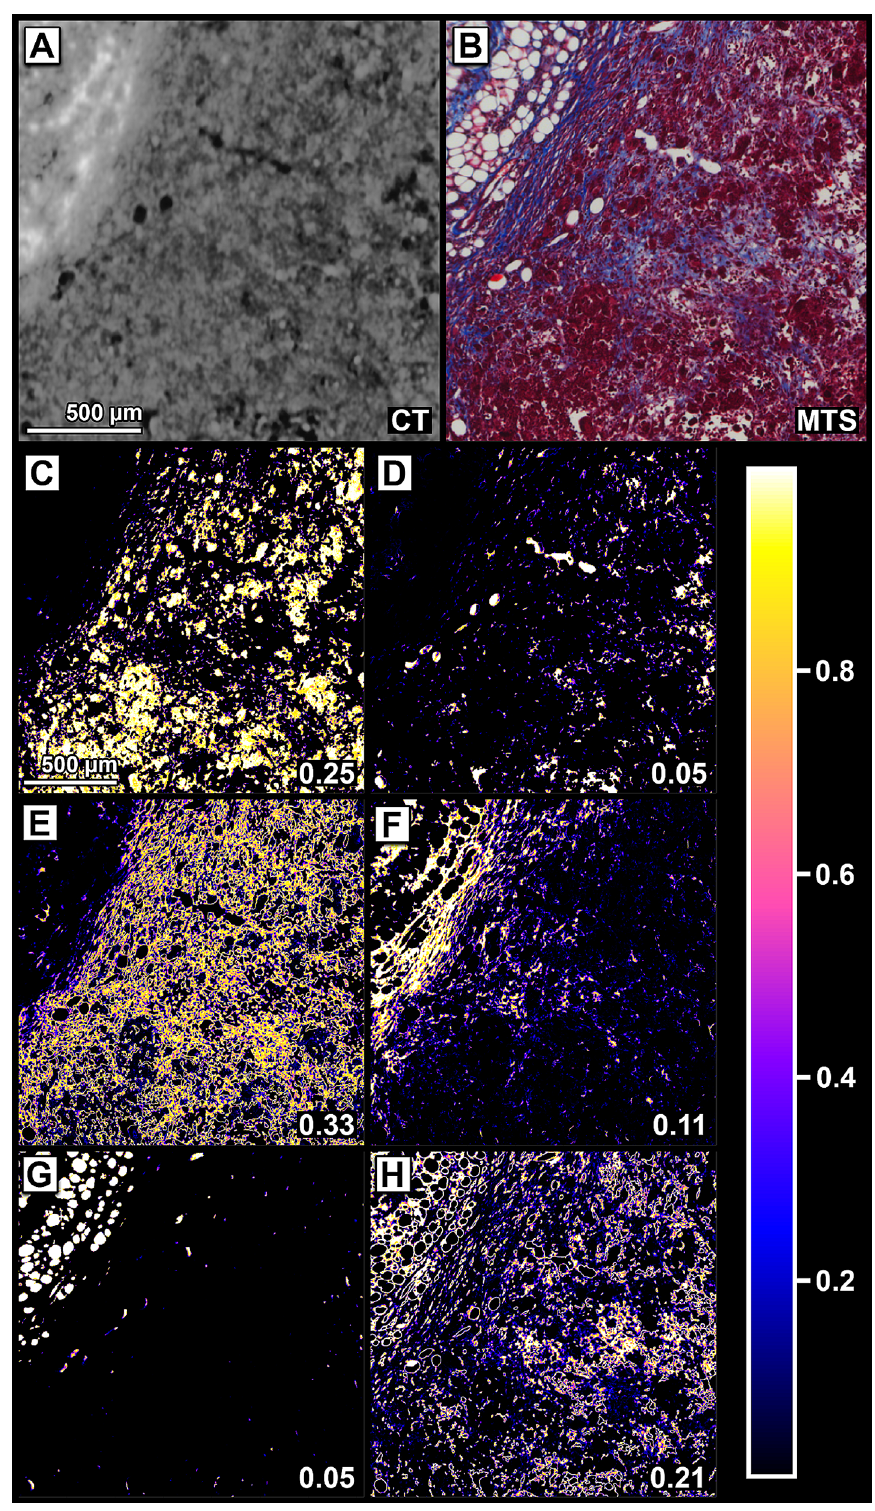
Figure 6. Automatic classification of tissue structures using registered CT and histology. ( A ) CT image. ( B ) MTS histology image matched to the CT image shown in ( A ). ( C – H ) Colour coded probability maps of the six different components of the gaussian mixed model optimized by EM. The colour code for the different probabilities can be seen in the bar. ( C ) Mainly depicts healthy tumour cells. ( D ) Depicts vessels and holes within the tissue. ( E ) Shows NP location, extracellular matrix components. ( F ) Depicts the BaNPs. ( G ) Displays fat cells. ( H ) Displays cell membranes. All images ( C – H ) also state the mix coefficient in the lower right corner. Fibres components ( E ) are the most dominant component with a mix coefficient of 35% followed by the healthy tumour cells with